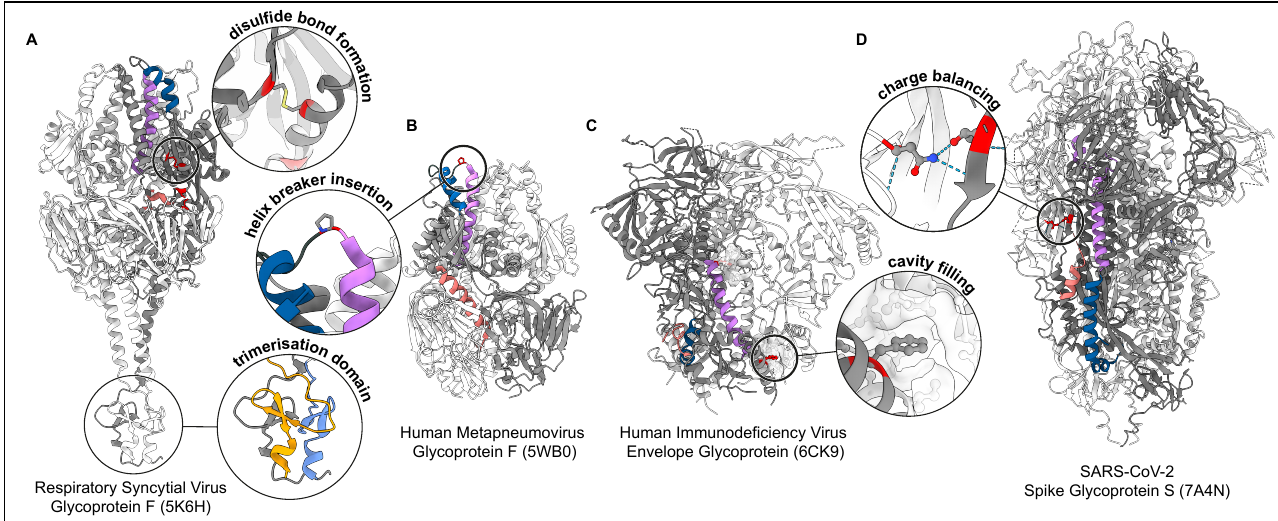
Figure 2. Examples of stabilising modifications. Viral membrane fusion protein trimers stabilised in prefusion conformation by different mutations (red) depicted in ribbon representation [105] with insets showing specific examples of each stabilisation in detail. One protomer of each trimer is emphasised (dark grey) with structural elements essential for the fusion process coloured according to Figure 1: fusion peptides (light red), central helix (purple) and short helix (blue). PDB accession numbers are given in parenthesis for each structure. ( A ) Respiratory Syncytial Virus F glycopro- tein [67] stabilised through interprotomer, intramolecular disulfide bond formation (yellow) and a T4 fibritin trimerisation domain (with protomers coloured grey, orange and light blue). ( B ) Human metapneumovirus F glycoprotein [57] stabilised by residue substitution to proline located at the hinge region between the short and central helix acting as helix breaker to prevent helix extension. ( C ) Human immunodeficiency virus envelope glycoprotein [77] stabilised through cavity filling mutations showing a phenylalanine inserted into the protein cavity of a neighbouring protomer (white surface). ( D ) Severe acute respiratory syndrome coronavirus type 2 (SARS-CoV-2) spike protein [63] stabilised by charge balancing, whereby a repulsive force is replaced by an attractive force by replacing aspartate by asparagine to enable hydrogen bonding (dotted lines between red (oxygen) and blue (nitrogen) coloured